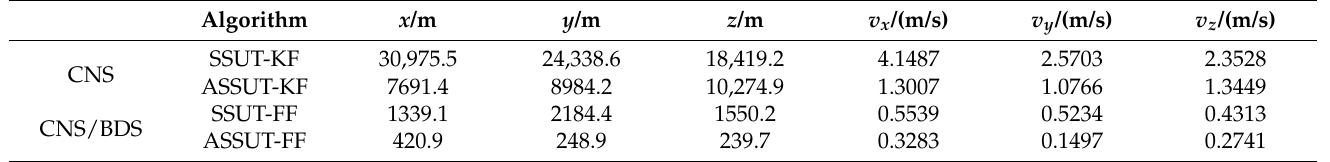
Figure 14. Position and velocity errors in three directions. ( a ) Position error in the X direction; ( b ) position error in the Y direction; ( c ) position error in the Z direction; ( d ) velocity error in the X direction; ( e ) velocity error in the Y direction; and ( f ) velocity error in the Z direction. Table 9. RMSEs of position and velocity in three directions for the full simulation